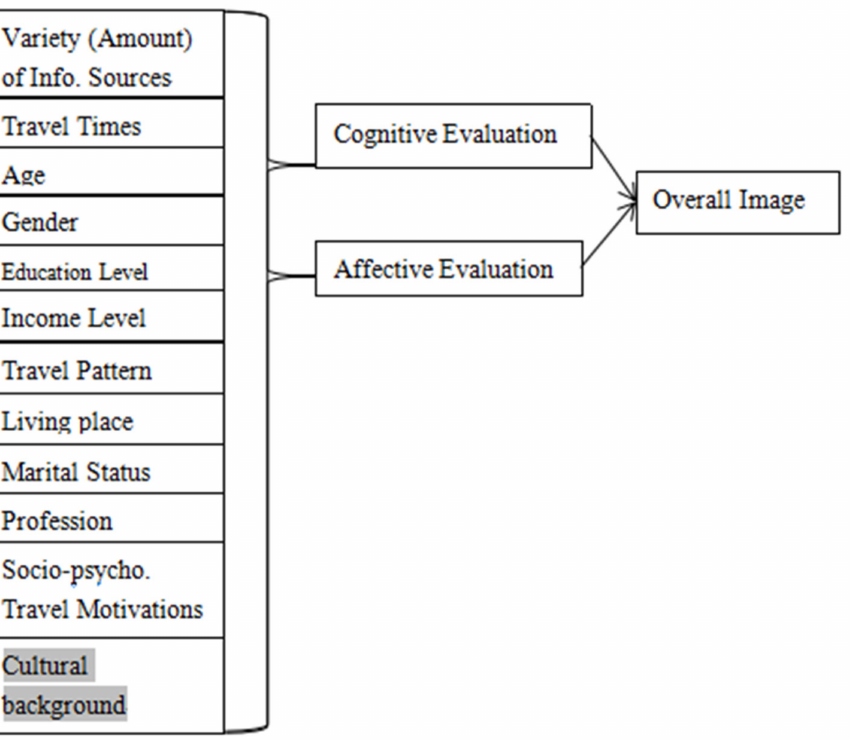
Figure 2. Path model of determinants of the study. Source: own preparation based on the models of Baloglu and Mccleary (1999) and Beerli and Martin (2004) [13,17]. Note: the attribute in gray denotes that it is examined and analyzed in this